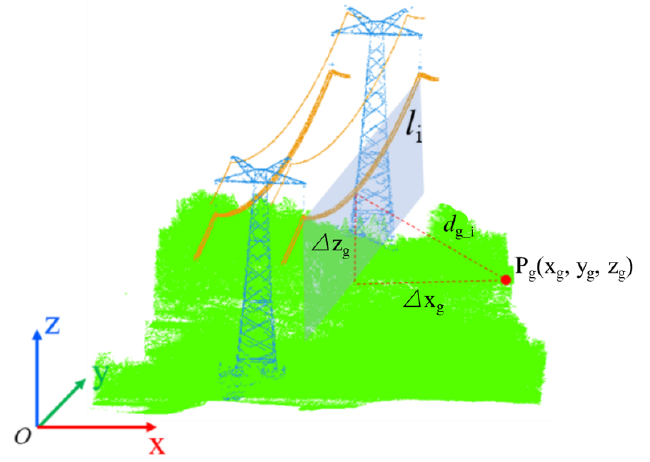
Figure 14. The calculation of safety distance using the catenary plane.